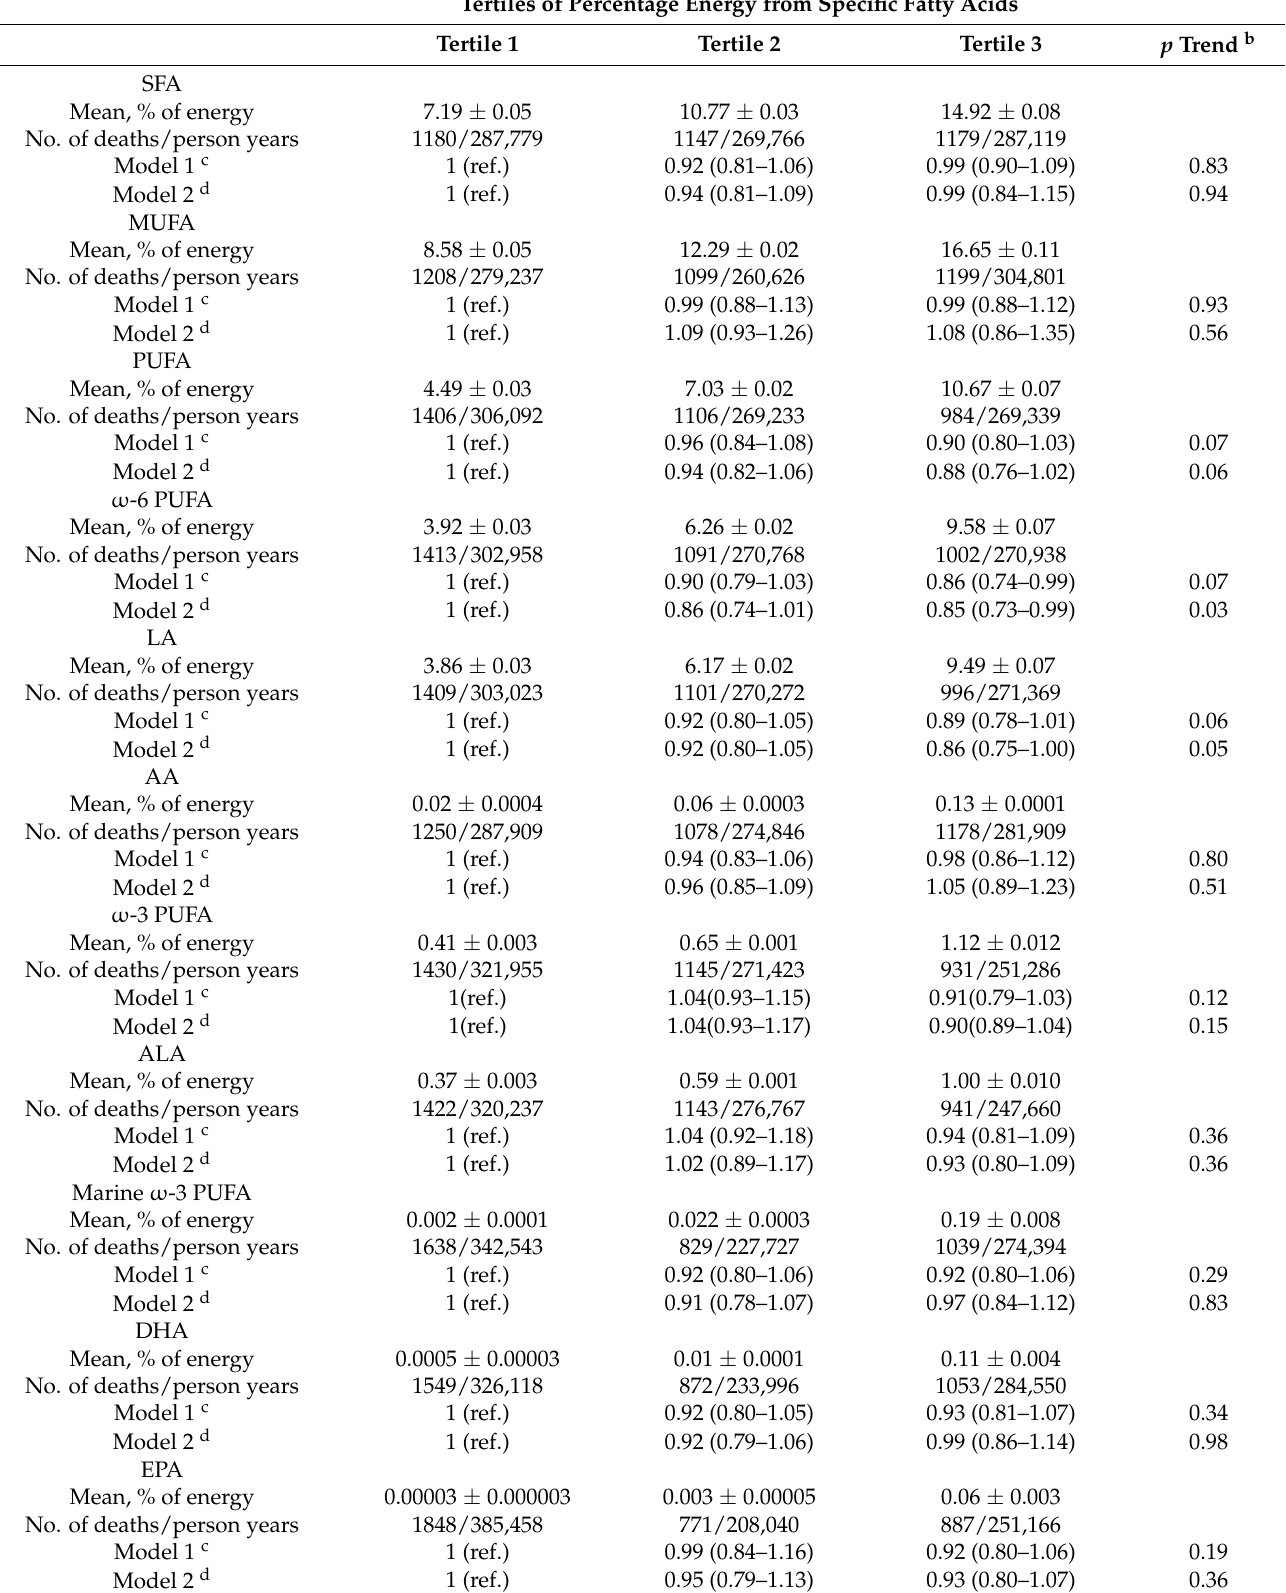
Table 2. Associations of specific fatty acids with all-cause mortality among patients with CMD a . Tertiles of Percentage Energy from Specific Fatty